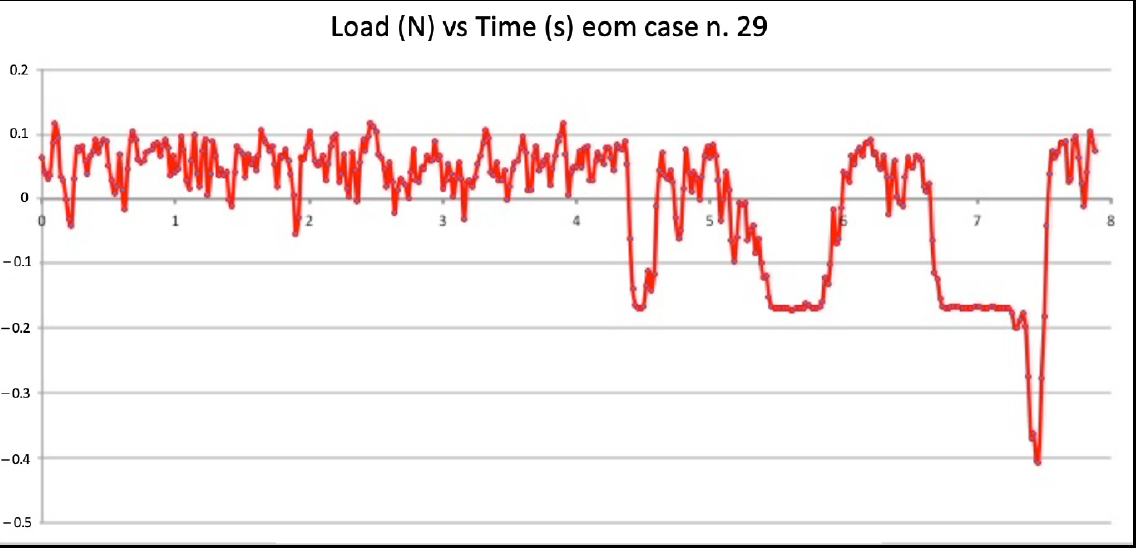
Table 2. Descriptive statistical analysis of the watch winding motion, balanced forces technique, and envelope of motion, each on 30 tooth models, by the highest and lowest compressive loads (N).